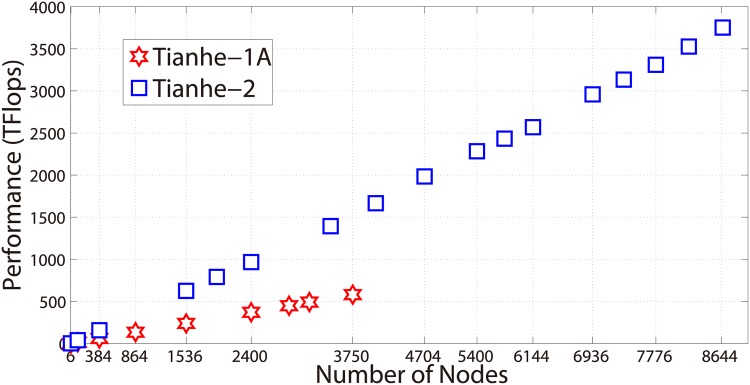
Weak scaling performance on Tianhe-1A and Tianhe-2.